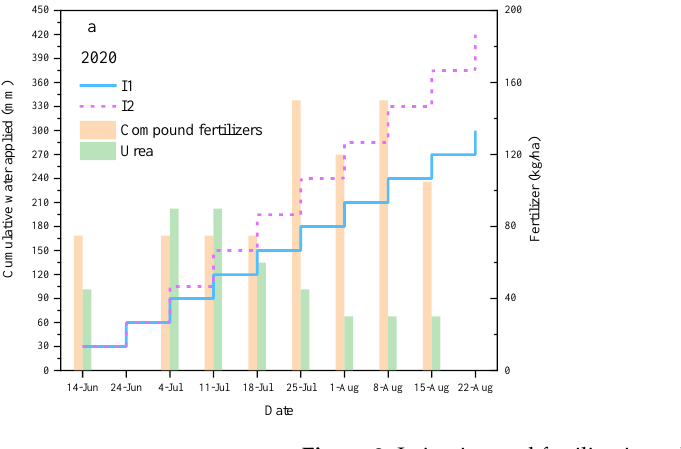
Figure 2. Irrigation and fertilization scheduling for the 2020 ( a ) and 2021 ( b ) seasons. I1, I2, W1, W2, W3 and W4 are the different irrigation levels in 2020 and 2021, respectively. The irrigation rate was applied according to the design as shown in Figure 2. The width and length of each plot were 2.18 m and 20 m, respectively. The water source for irrigation was well water, and pressurized irrigation was used with a drip irrigation system. Water meters were installed in each plot to measure the amount of irrigation water. The designed irrigation period was 10 days for the squaring stage and 7 days for the flower boll stage [39].